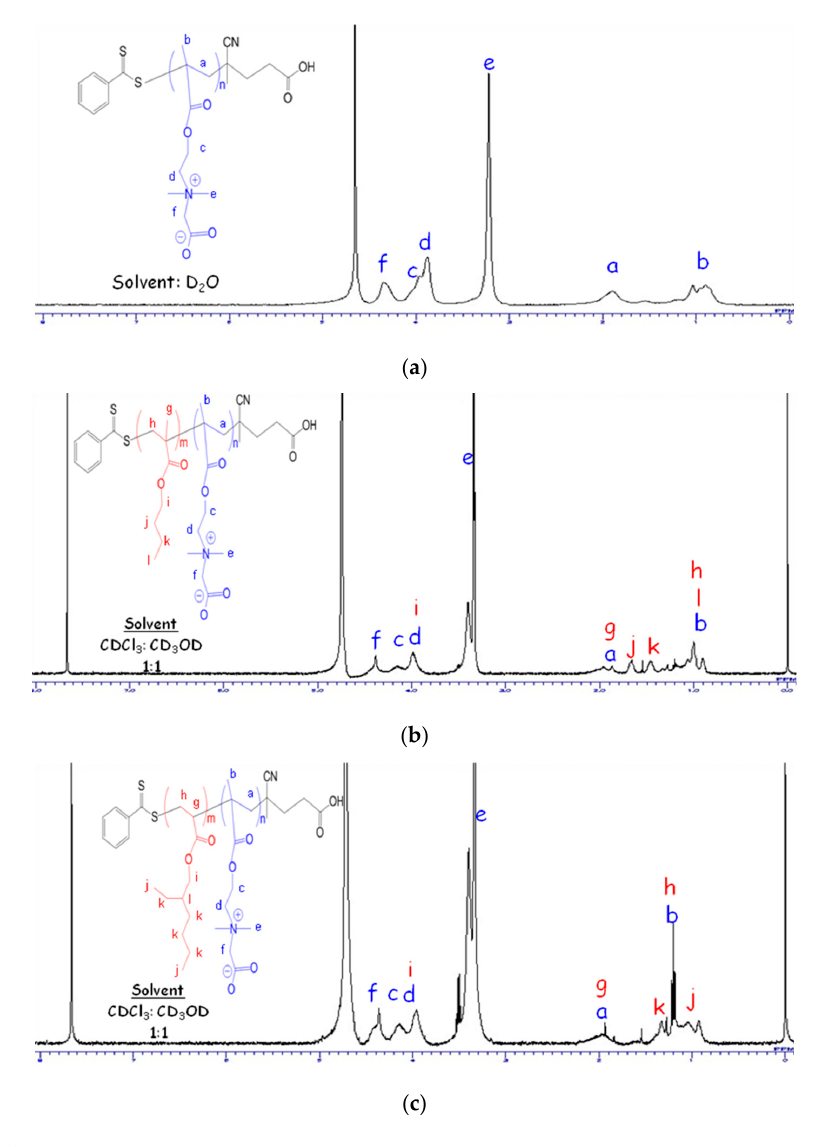
Figure 1. 1 H NMR spectra of: ( a ) homopolymer PGLBT in D 2 O; ( b ) diblock copolymer P( n -BMA)- b -PGLBT in CDCl 3 :CD 3 OD (1:1); and ( c ) diblock copolymer P(EHA)- b -PGLBT in CDCl 3 :CD 3 OD (1:1).